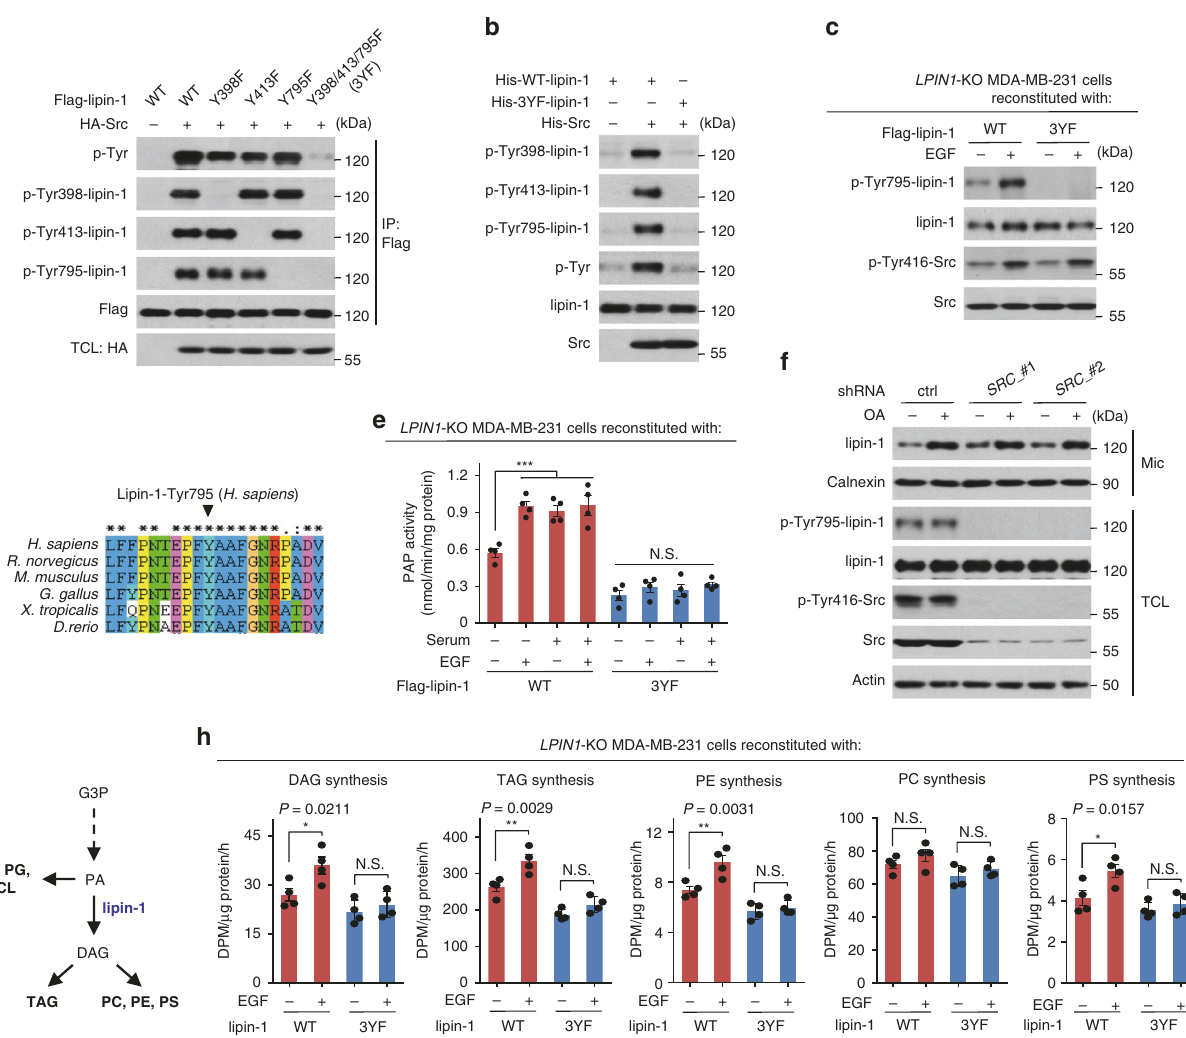
Fig. 2 Src-mediated tyrosine phosphorylation of lipin-1 is essential for PAP activity of lipin-1 and glycerolipid synthesis. a Identi fi cation of phosphorylation sites on lipin-1. Flag-WT-lipin-1 or its tyrosine-to-phenylalanine (YF) mutants was co-expressed with or without Src in HEK293T cells. Cells were lysed and subjected to IP against Flag, followed by immunoblotting. b 3YF-lipin-1 mutant fails to be phosphorylated by Src in vitro. Bacterially expressed His-tagged WT-lipin-1 or its 3YF mutant was incubated with His-Src in a kinase assay buffer, followed by immunoblotting. c 3YF-lipin-1 mutant fails to be phosphorylated in EGF-stimulated in MDA-MB-231 cells. LPIN1 -KO MDA-MB-231 cells stably expressing Flag-tagged WT-lipin-1 or 3YF-lipin-1 were maintained in a serum-free medium for 4 h, followed with or without EGF treatment. d Sequence alignment of the residues fl anking Tyr795 across different species. Arrowhead points to the tyrosine residues corresponding to the Tyr795 residue in human lipin-1. e PAP activity in LPIN1 -KO MDA-MB- 231 cells reconstituted with WT-lipin-1 or 3YF-lipin-1. Cells were maintained in a serum-free medium for 4 h, and then treated with or without serum or EGF, followed by immunoprecipitation with anti-Flag. The enzymatic activities of immunoprecipitated Flag-lipin-1 were examined. f Knockdown of SRC does not affect oleic acid (OA)-induced lipin-1 translocation to the endoplasmic reticulum (ER). MDA-MB-231 cells expressing shRNA against SRC or Renilla as a control were maintained in complete medium containing 10% FBS and treated with or without OA for 2 h and homogenised and subjected to ultracentrifugation to collect microsome fractions, followed by immunoblotting. Calnexin, microsomal (Mic) marker. g Schematic diagram of phospholipids synthesised from glycerol-3-phosphate in mammalian cells. h DAG, TAG and phospholipid synthesis rates of LPIN1 -KO MDA-MB-231 cells reconstituted with WT-lipin-1 or 3YF-lipin-1. Lipids from cells treated with 3 H-labelled OA and EGF were extracted and resolved by thin-layer chromatography (TLC), followed by quanti fi cation with scintillation counting. DAG diglyceride, TAG triglyceride, PE phosphatidylethanolamine, PC phosphatidylcholine, PS phosphatidylserine. e , h were quanti fi ed in each independent experiment ( n = 4). Data are mean ± s.e.m.; ordinary two-way ANOVA, followed by Tukey in e , or by Sidak in h ; *** P < 0.001, N.S. not signi fi cant. Source data are provided as a Source Data fi